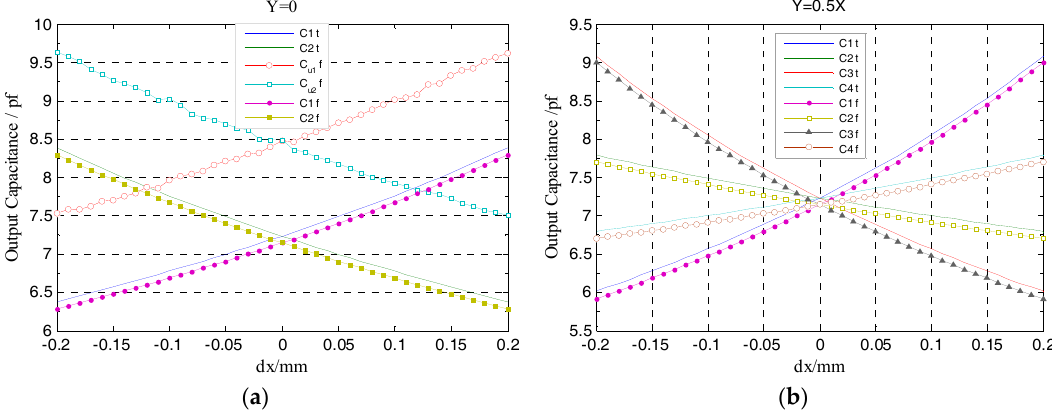
Figure 11. Simulation and theoretical value comparison for the output capacitance of the radial cylindrical electrodes: ( a ) Comparing with the previously developed CCS (2-DOF); ( b ) the comparison of each quadrant cylindrical electrode.